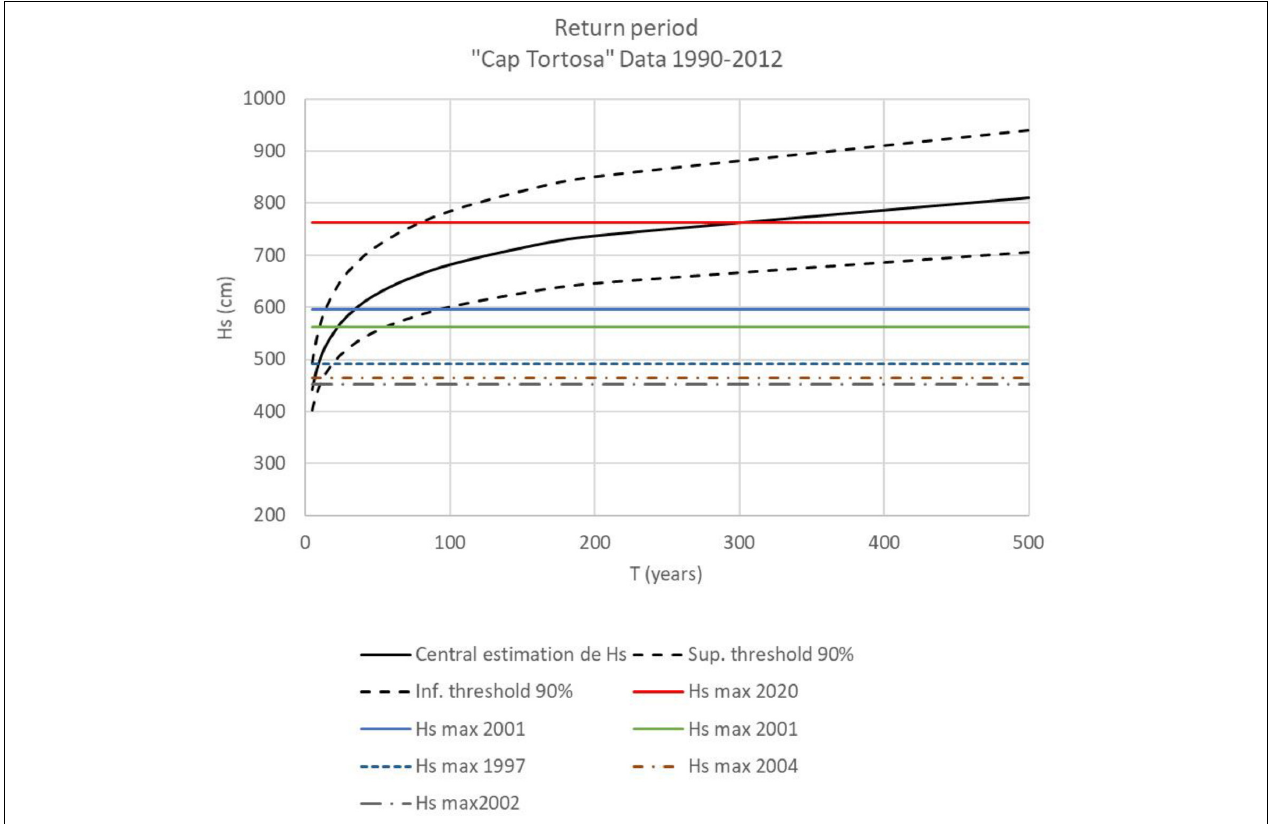
FIGURE 5 | Alternative (compare with Figure 3 ) extreme distribution function, plotting significant wave height against return period. The data set is identical to that in Figure 3 , corresponding to the period 1990–2012 and the XIOM wave buoy station in front of the Ebro delta at a depth of 60 m (dismounted in 2012. In this case a threshold of 2.7 m has been selected to define wave storms for the extreme sample. The function providing the best fit, using least squares and Goda’s formula for the plotting-position, is a Gumbel distribution